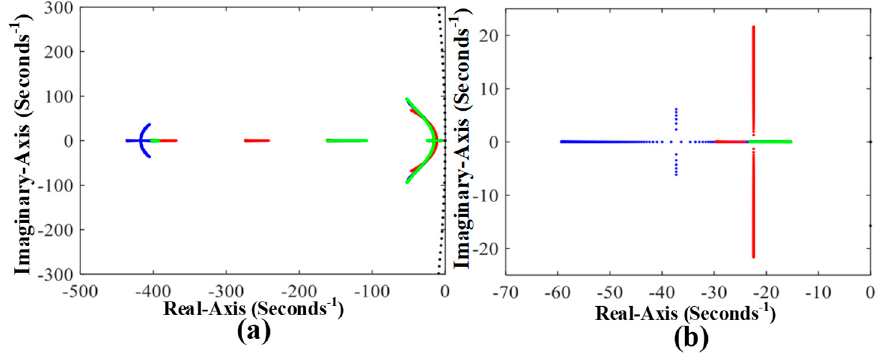
Figure 11. Pole distributions of system between different armature inductance in q -axis: ( a ) pole distribution diagram of motor before design; ( b ) pole distribution diagram of motor after design.